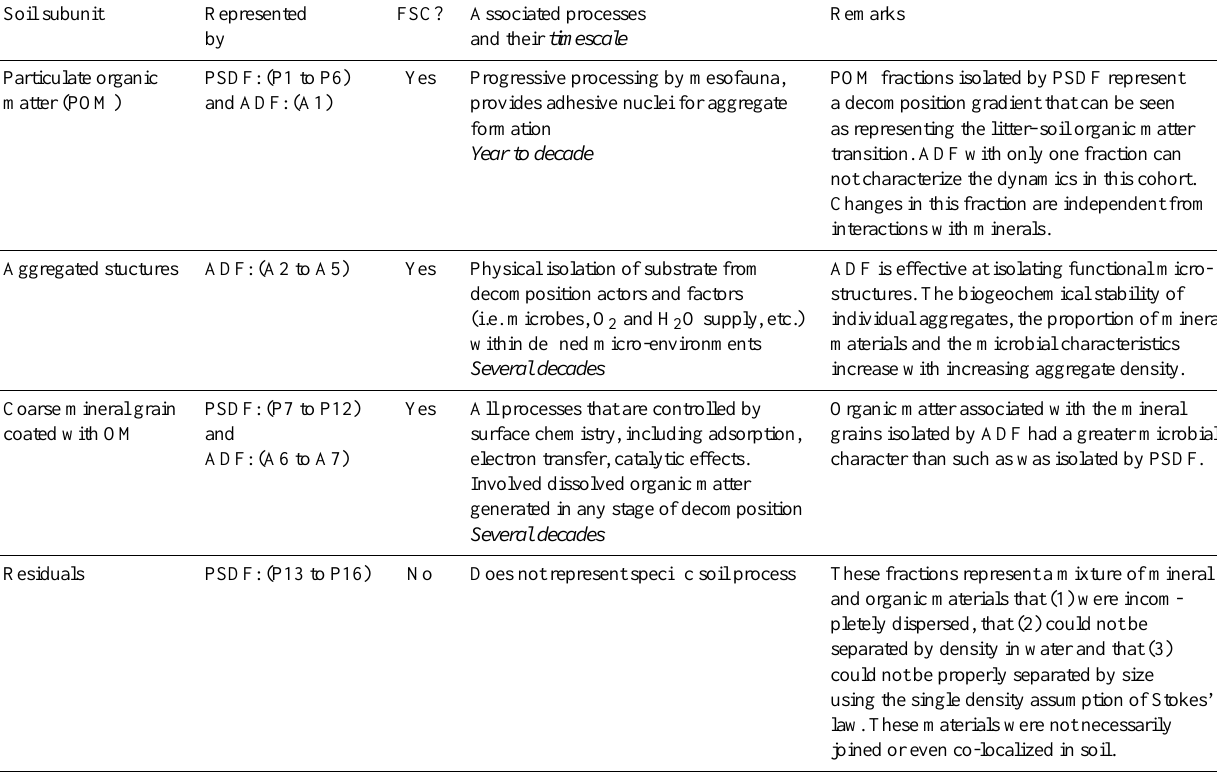
Table 5. Identification of functional soil compartment (FSC) among physical fractions.